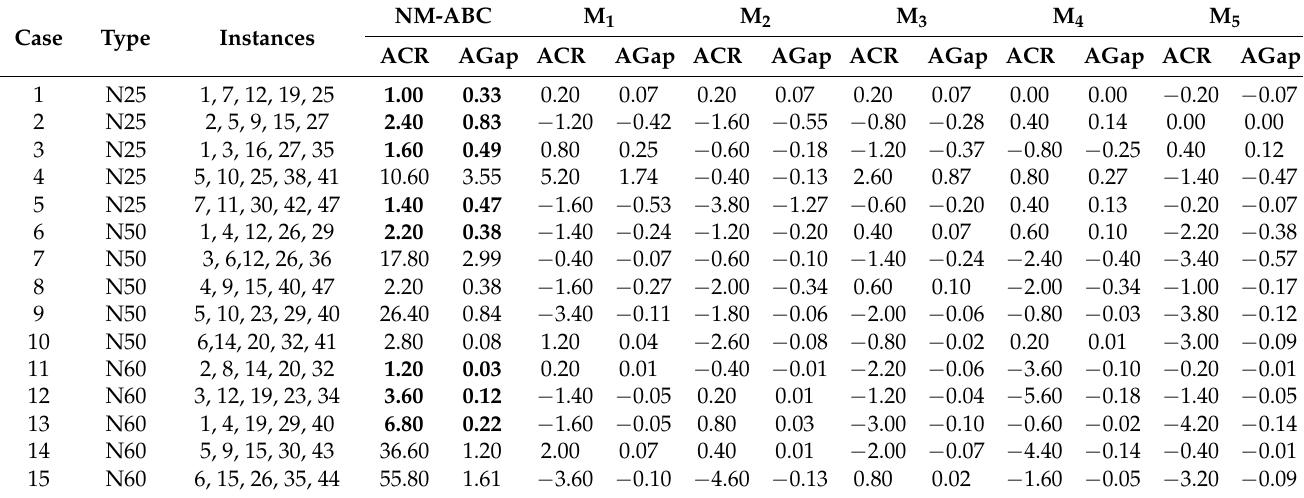
Table 7 summarizes the comparison and assessment of average cost reduction and average gap percentage obtained by NM-ABC with another competitor method. Table